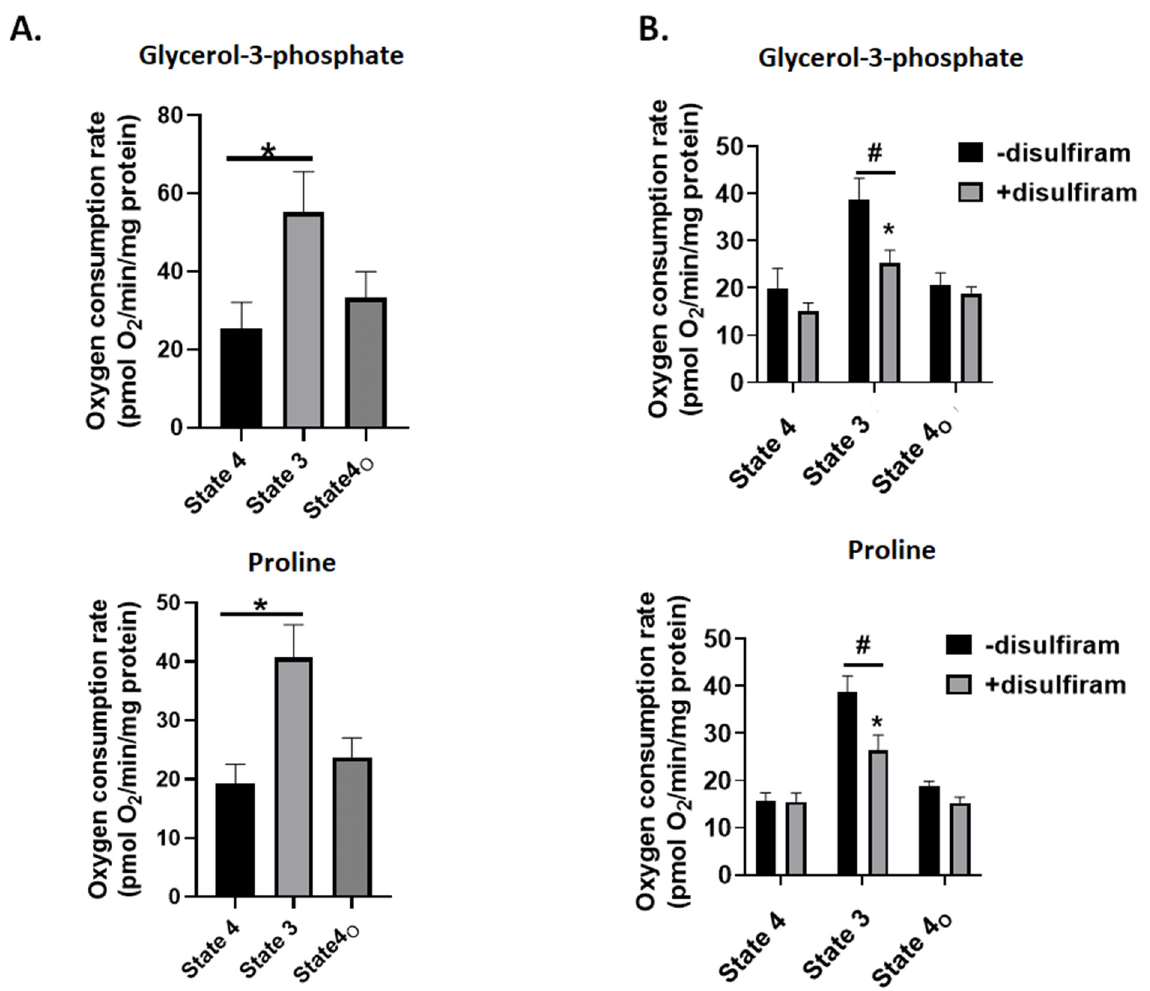
Figure 7. Treatment of mitochondria with disulfiram inhibits state 3 respiration, indicating it may inhibit complex III. ( A ) Mitochondria energized with glycerol-3-phosphate or proline exhibit measurable rates of state 4 (substrate alone), state 3 (injection of ADP), and state 4 O (treatment with complex V inhibitor, oligomycin). State 4 and state 4 O represent measures of non-phosphorylating or proton leak-dependent respiration. n = 4, mean ± SEM, 1-way ANOVA with a post hoc Fisher’s LSD test. * p ≤ 0.05. ( B ) Mitochondria were seeded in Seahorse TC plates and treated with 1000 nM disulfiram and 1 mM GSH. Assays were then conducted as described in ( A ) and the Experimental section. n = 4, mean ± SEM, 2-way ANOVA with a post hoc Fisher’s LSD test. * p ≤ 0.05 when con-